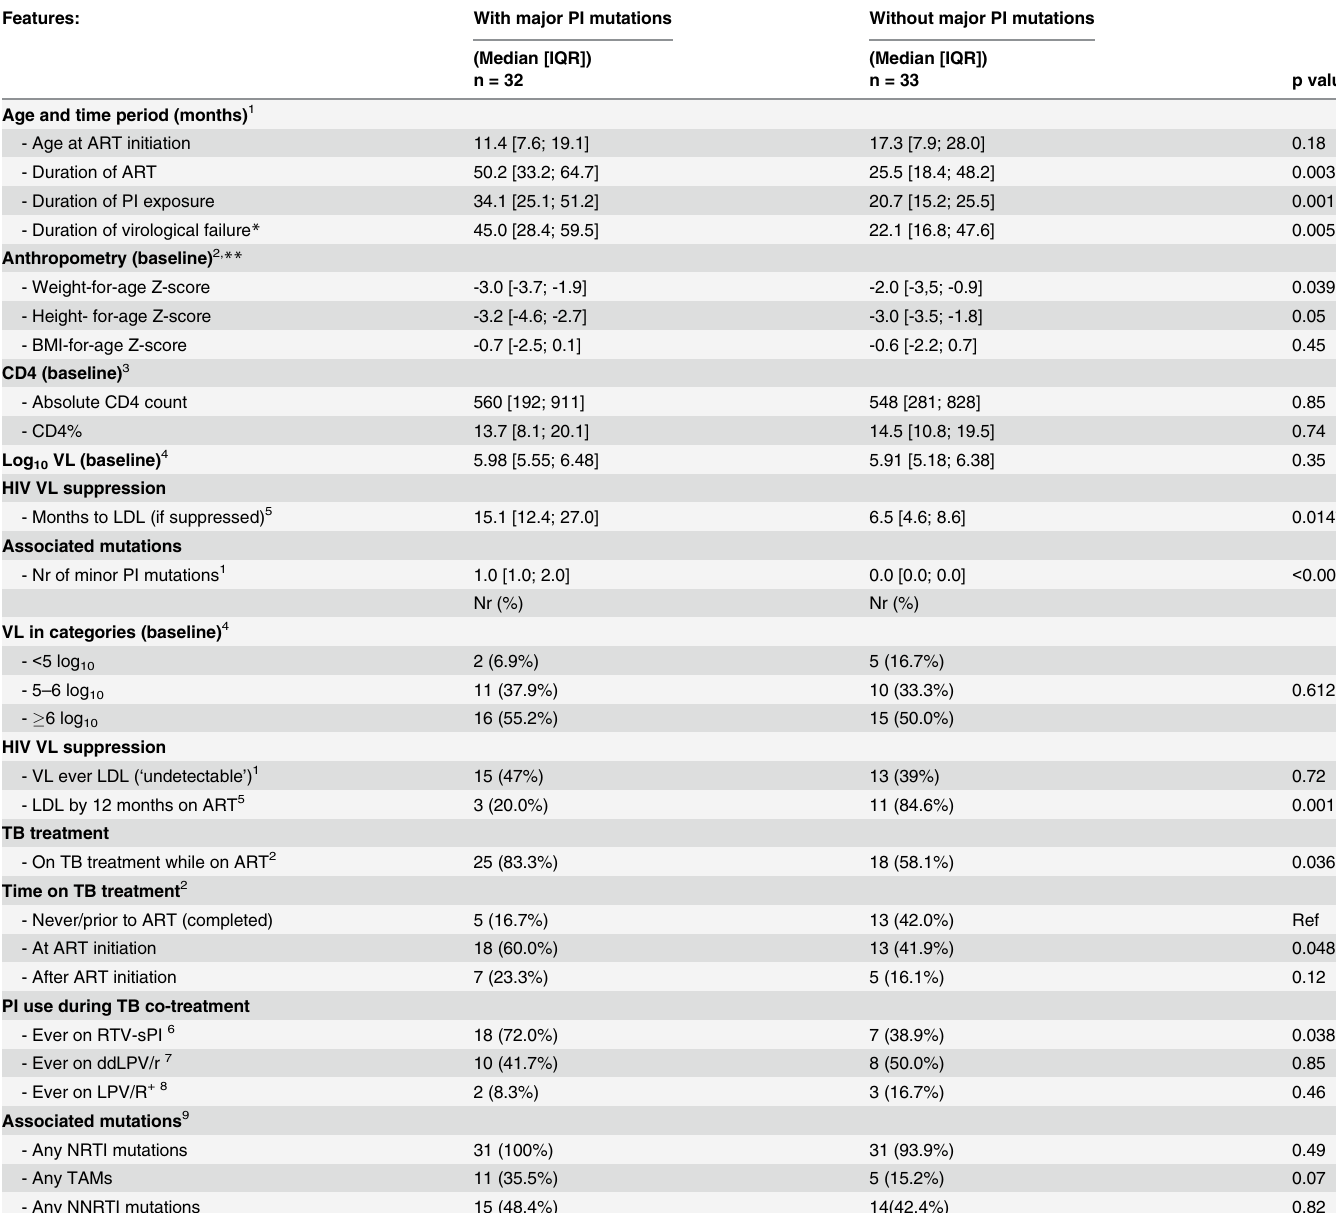
Table 2. Univariate analysis comparing patients with and without major protease inhibitor (PI) drug resistance mutations.